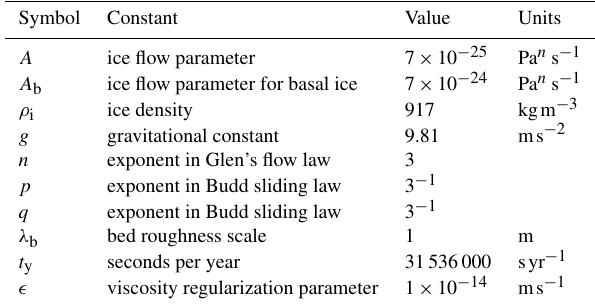
Table 2. Constants used in the ice sheet/inversion model applied to the Russell Glacier